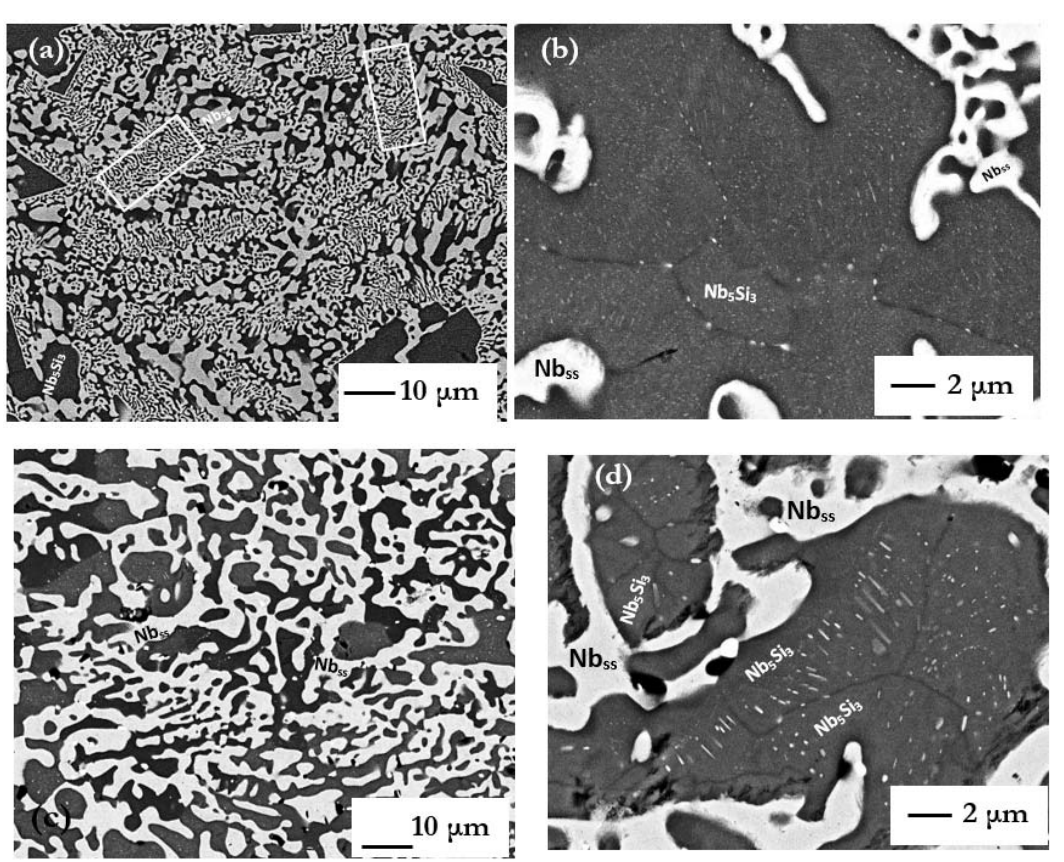
Figure 2. Alloy CM1-600g button ( a ) and ( b ) as cast, ( c ) and ( d ) heat treated. The rectangles show lamellar microstructure. For ( b ) and ( d ) see text.